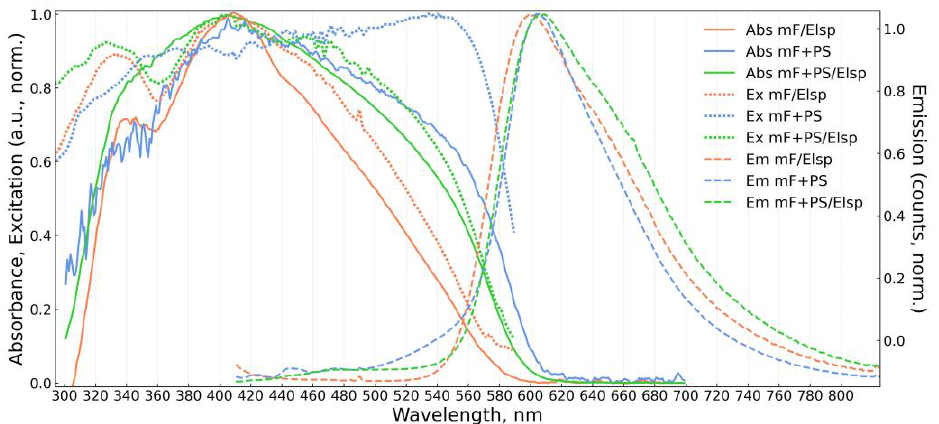
Figure 5. Absorbance (Abs, solid), excitation (Ex, dotted), and emission (Em, dashed) spectra of obtained solid fluorescent material mF/Elsp (electrospun 5 × 10 −3 M fluorophore solution) and materials mF+PS , mF+PS/Elsp (drop-casted and electrospun solutions containing 1 × 10 −2 M and 2 × 10 −2 M of the fluorophore, respectively).